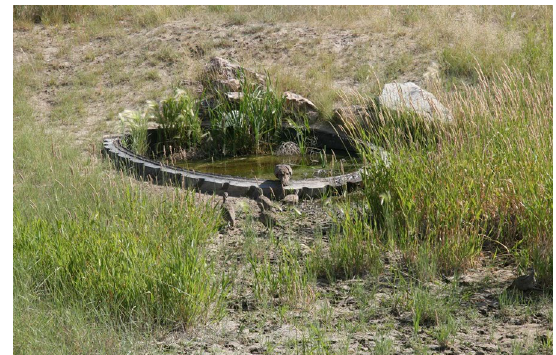
Fig. 17 Greater sage grouse (2007)